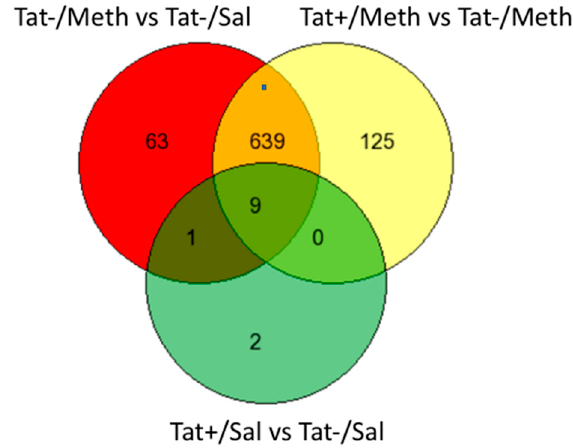
Figure 2. Venn diagram showing the number of exclusive and overlapping signatures in assigned comparisons, regardless of direction, in different assigned comparisons. The comparisons between groups were established in order to identify the effect of Tat (Tat+/Sal vs. Tat − /Sal), the effect of Meth (Tat − /Meth vs. Tat − /Sal), the effect of Tat in the context of Meth (Tat+/Meth vs. Tat − Meth), and the effect of Meth in the context of Tat (Tat+/Meth vs. Tat+/Sal). There were 712 gene signatures identified for the comparison of Tat − /Meth with Tat − /Sal, of which 63 were exclusive to the effect of Meth. Tat+/Meth as compared with Tat − /Meth produced 773 gene signatures of which 125 were exclusive to the effect of Tat in the context of Meth. Between these two comparisons, a total of 648 genes overlapped in an anti-directional manner. The comparison, Tat+/Sal vs. Tat − /Sal, identified 12 gene signatures of which only two were exclusive to the effects of Tat. Nine of all signatures overlapped between all three comparisons. Since the comparison between Tat+/Meth and Tat+/Sal did not produce significant signatures, it is not included in this graph.